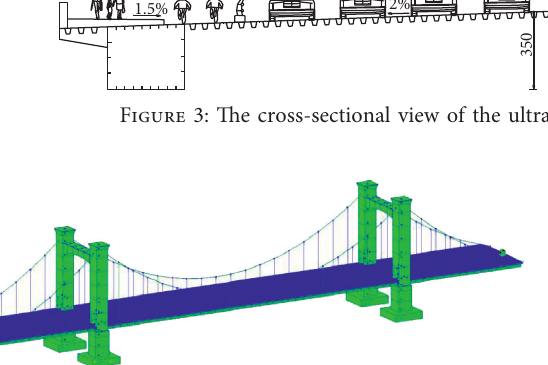
Figure 4: Finite element model of the Yunlongwan